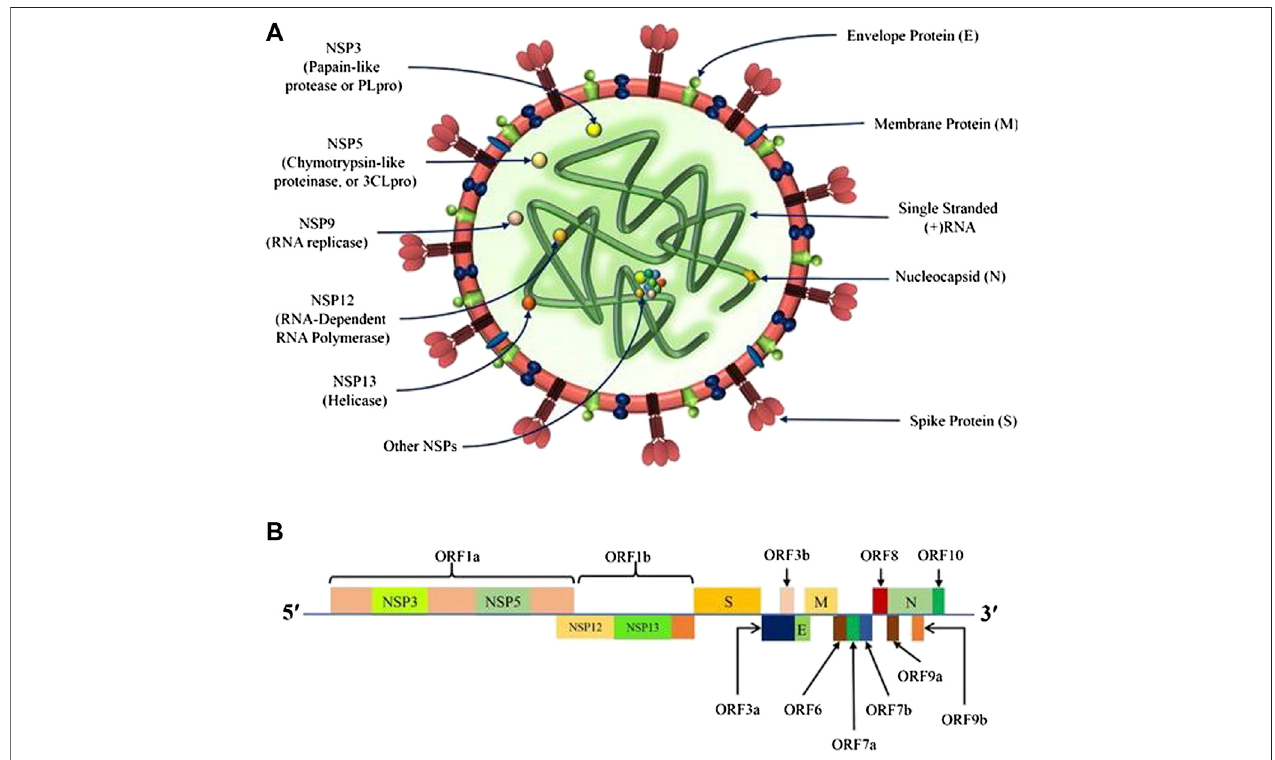
FIGURE 1 | Genomic organization of SARS-CoV-2; (A) The structure of SARS-CoV-2 containing spherical crown-like lipid envelope showing structural proteins, namelySpike(S),Envelope(E),Nucleocapsid(N),andMembrane(M)proteinssurroundingthenon-segmented(+)-sensesinglestrandedRNAencodingforseveralnon- structural proteins (NSPs); (B) The SARS-CoV-2 genome representing the arrangement of - 5 ′ untranslated region (5 ′ -UTR) caps, ORF1ab (replicase), S, E, M, N, and other genes encoding for the NSPs like ORF 3, 6, 7a, 7b, 8, and 9b; and 3 ′ -UTR (poly-A